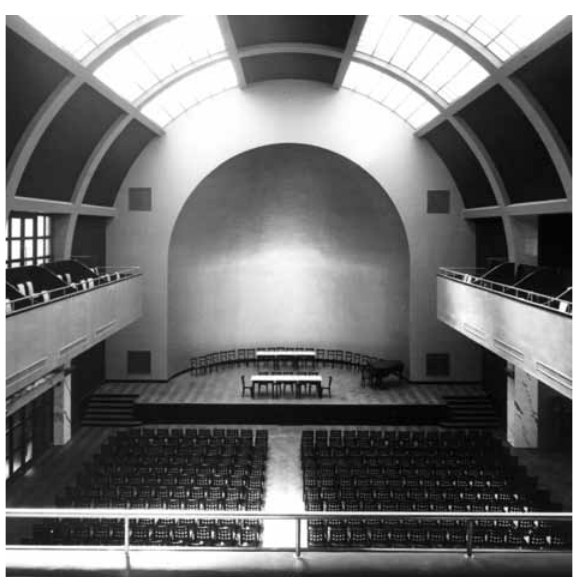
fig. 12. j. Gočár, railway-workers building in Hradec Králové,